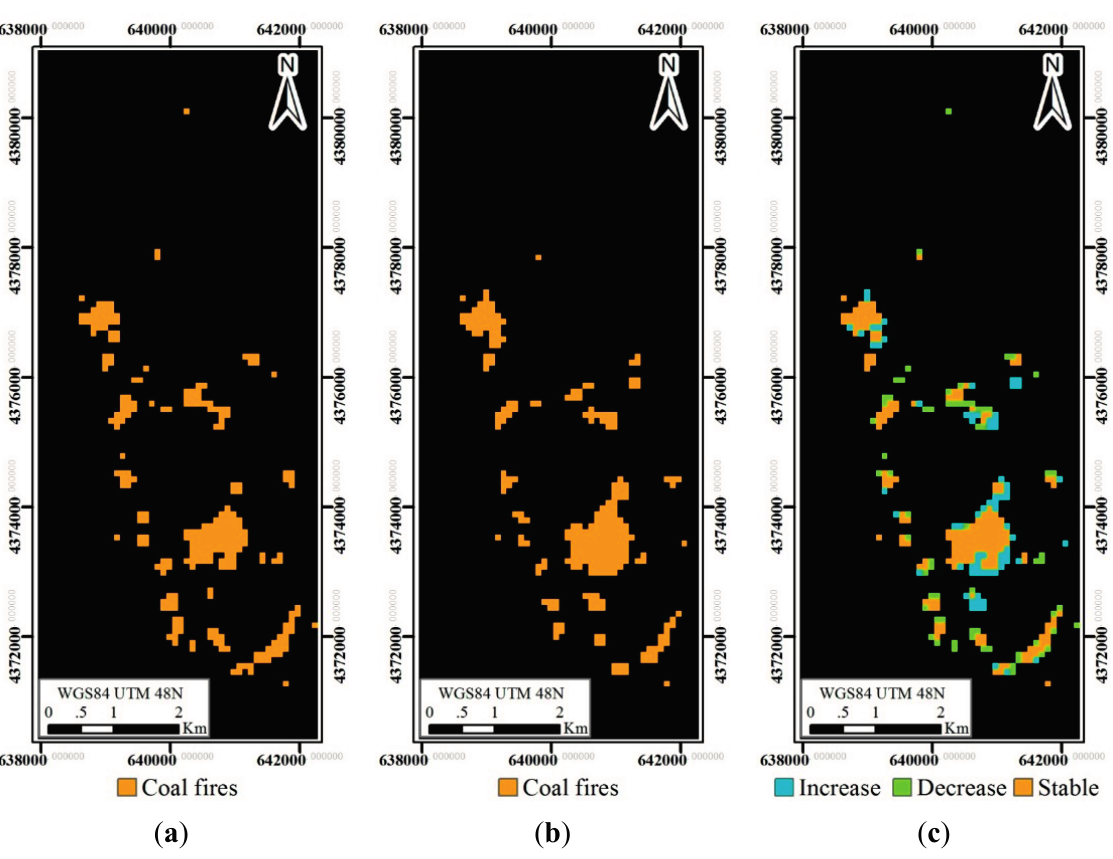
Figure 2. Change detection between two temporally adjacent classified thermal anomaly images. ( a ) Thermal anomalies for 10 February 2008. 22:53 P.M.; ( b ) thermal anomalies for 29 March 2008. 22:52 P.M.; ( c ) Change map, the green, blue, and orange areas represent decreasing, increasing and stable pixels,